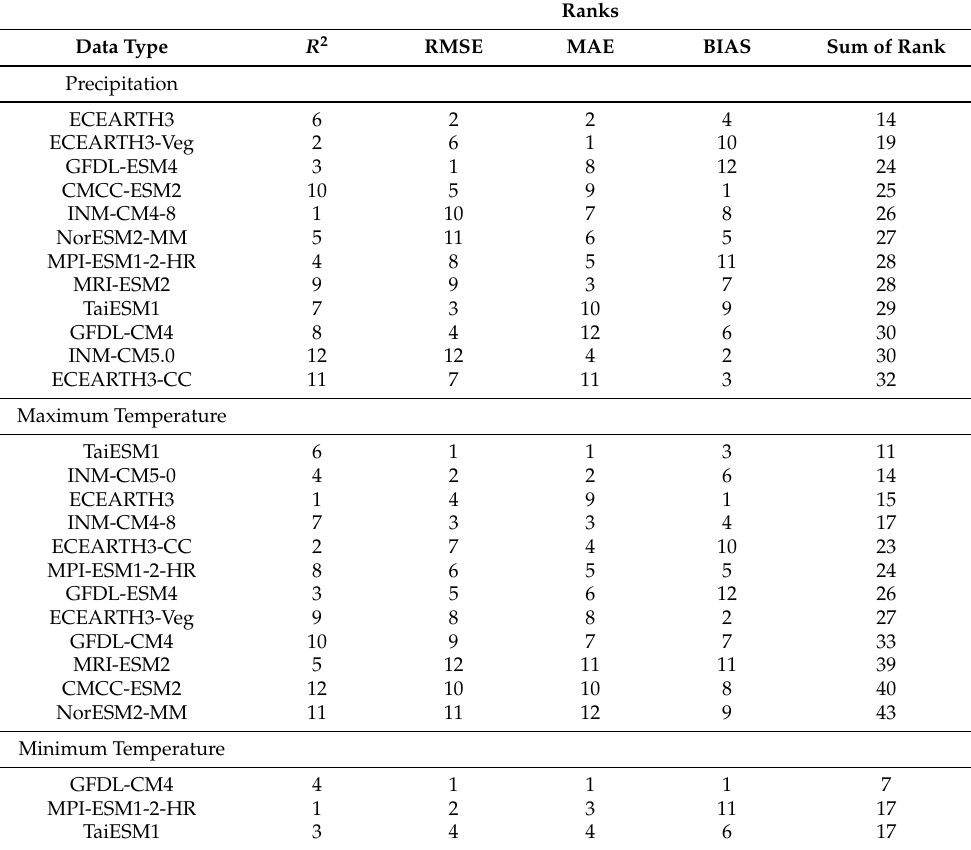
Table 5. Summary of model performances for all three climatic variables across four performance measures for the observed and climate model